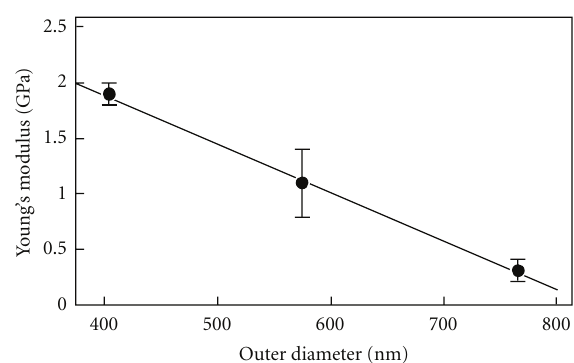
Figure 3: Young’s modulus of C 70 nanowhiskers plotted against the outer diameter. The solid line indicates linear